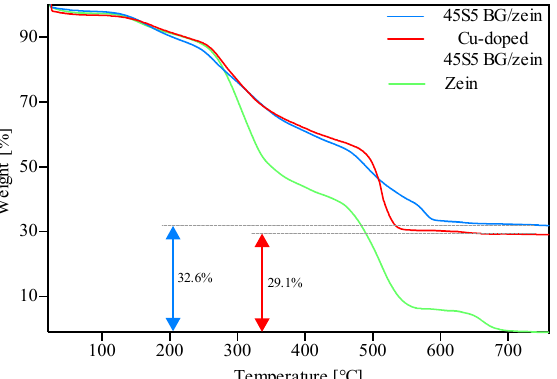
Figure 2. TGA results on coatings produced with 45S5 BG/zein, Cu ‐ doped 45S5 BG/zein, and pure zein.